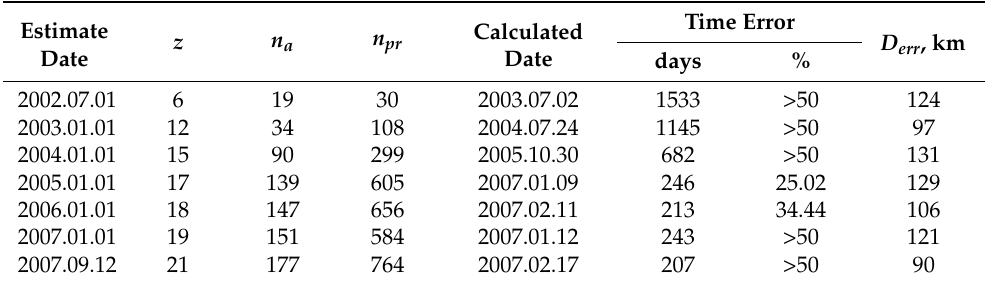
Figure A8. Retro predictability of the earthquake on 12 September 2007 in the zone with the highest (at the estimate date; see Figure A7, column ‘a’) number of successful predictive extrapolations (see Figure A4 for explanations). Table A7. Retro estimation of the place and time of the earthquake on 12 September 2007 by the cluster of its precedent activity.